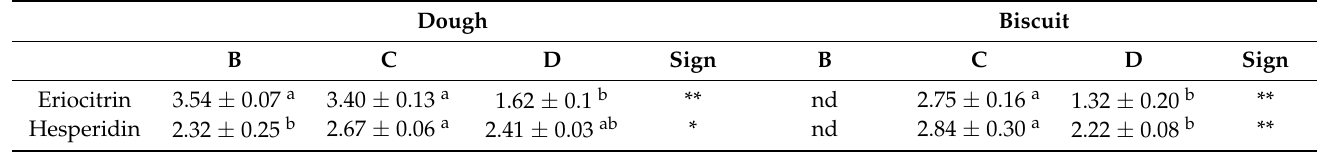
Table 6. Phenolic characterization of dough and biscuit samples. Data are expressed as mg 100 g − 1 of product. Dough Biscuit B C D Sign B Sign Eriocitrin 3.54 ± 0.07